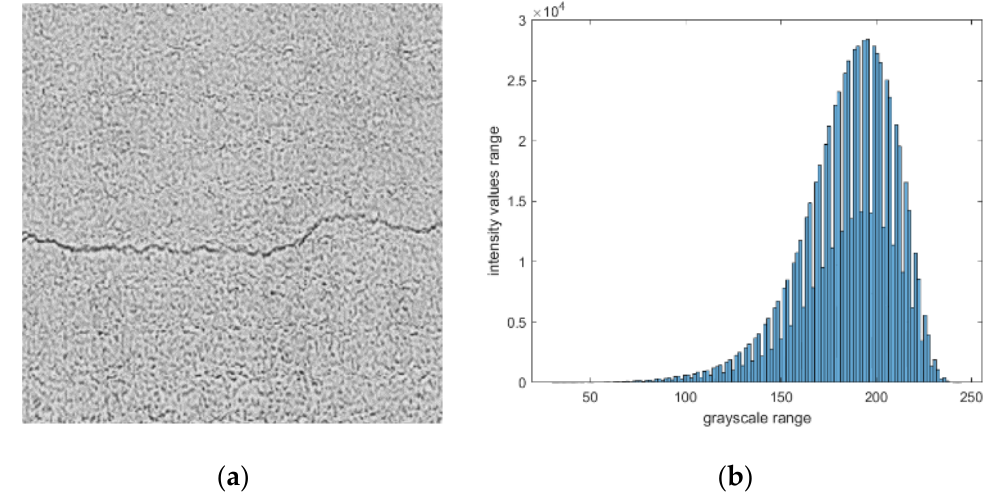
Figure 1. Sample concrete image: ( a ) image in grayscale mode and ( b ) its corresponding histogram.